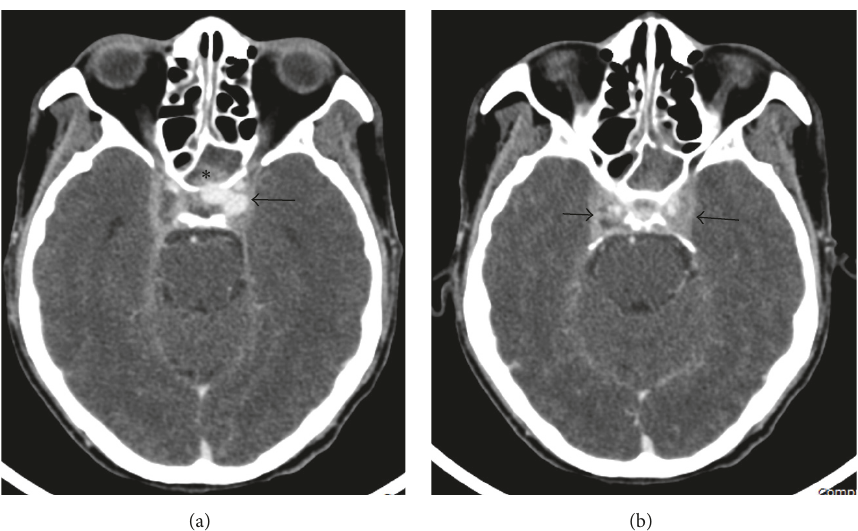
Figure 2: Total opacification of the left sphenoid sinus ( ∗ ) consistent with sinusitis. An infective pseudoaneurysm (arrow) from the cavernous segment of the left ICA protrudes into the left sphenoid sinus and sella turcica (a). Bulging with heterogeneous enhancement of the bilateral cavernous sinuses (arrows) represents thrombophlebitis (b).